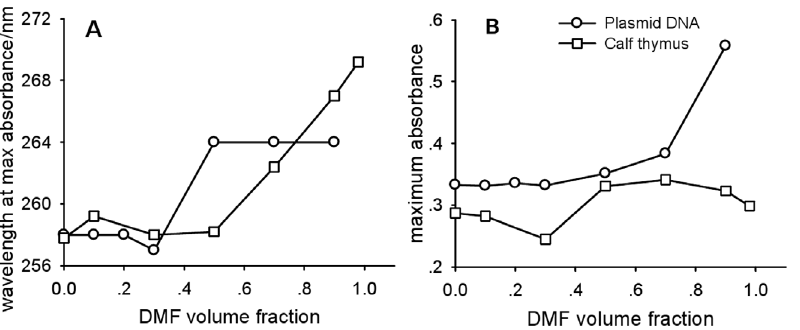
Figure 1. UV absorbance measurements of calf thymus DNA and plasmid DNA (c=16 m g/mL) in the mixture of TE/DMF at 25 u C. A. Wavelength at maximum absorbance/nm. B. Maximum absorbance.